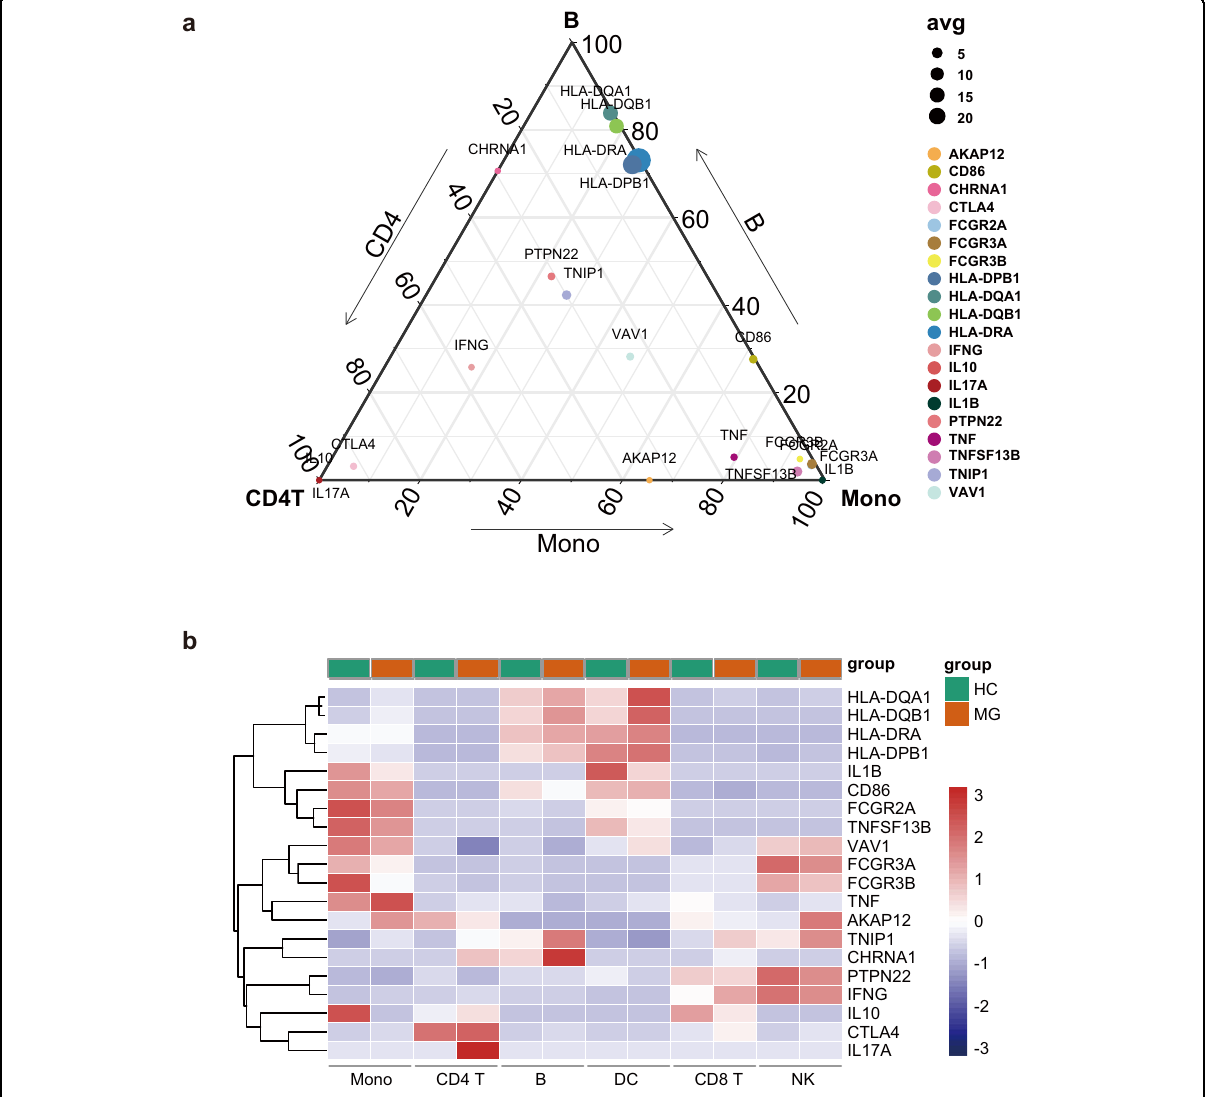
Fig. 7 Cell-type speci fi city of MG-associated genes using micro fl uidics scRNA-seq. a Expression of 20 genes associated with myasthenia gravis by cell type in MG patients. HLA genes have the highest expression in B cells and DCs. b Ternary plot of the 20 risk genes of two MG patients, comparing CD4 + T cells (left), B cells (top), and monocytes (right). The color of each node represents different genes, where the node size represents the average expression of the three cell